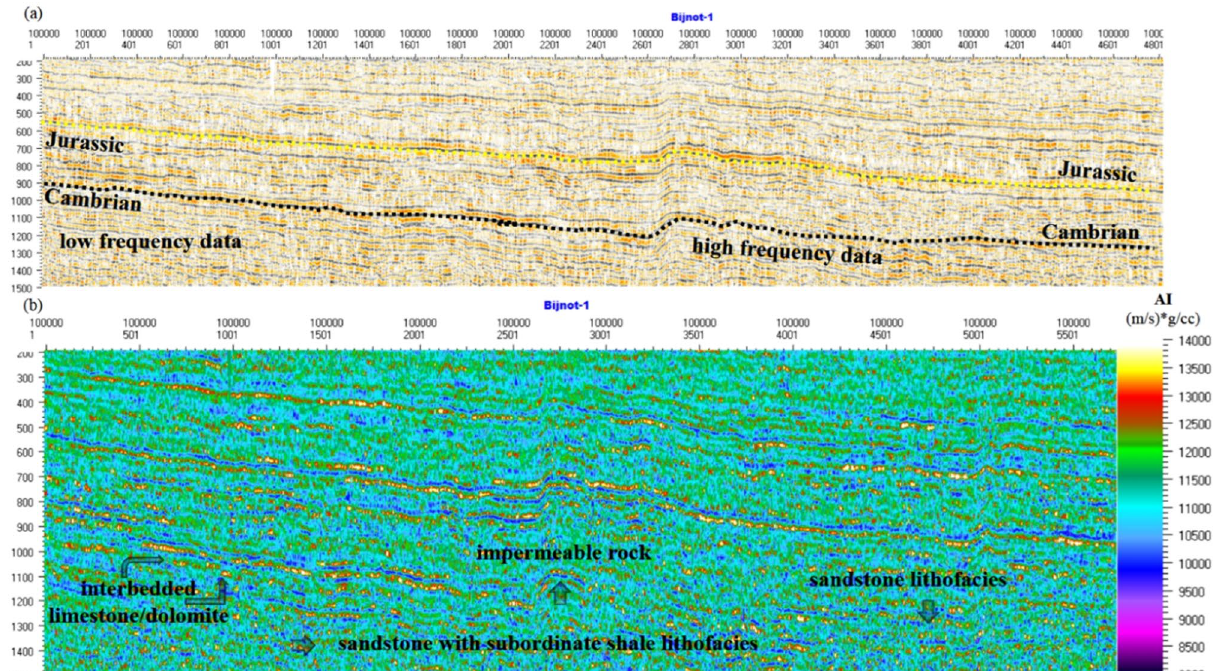
Figure 9. ( a ) Interpreted seismic line of FABS-11, and ( b ) the relative inverted acoustic impedance using the MLC and PSO inversion strategy.